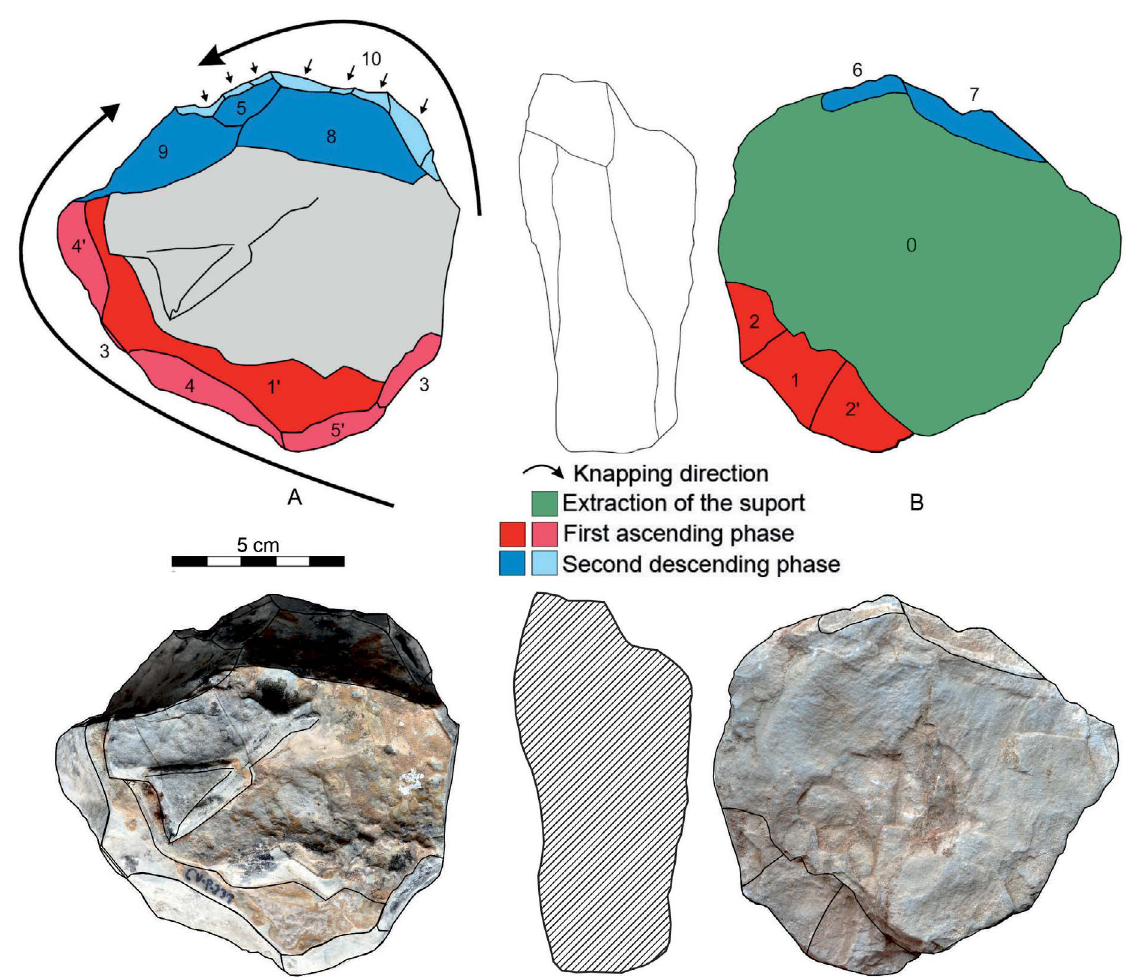
Figure 11. Diacritic scheme of knapping preform No.